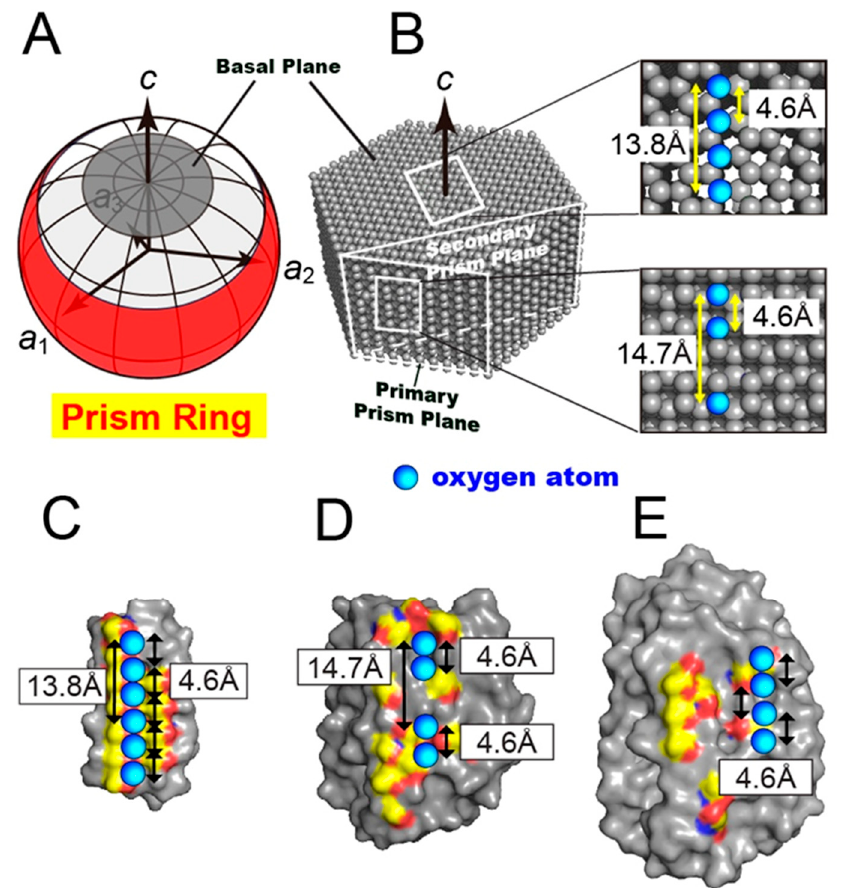
Figure 5. Oxygen atom spacings of a single ice crystal and IBPs. ( A ) Illustration of the prism ring, indicating the Anp IBP-bound area on a single ice crystal hemisphere. ( B ) Hexagonally arranged water molecules that are the constituents of the single ice crystal hemisphere. Only the oxygen atoms are only indicated. The basal plane is the top surface of ( A , B ). The oxygen atoms separated by 4.6 and 14.7 Å are unique constituents of the primary and secondary prism planes as well as the prism ring. ( C ) IBS of Tm IBP has six hollows to trap the water molecules (cyan) at regular intervals. They show a close match to the O-atom distances of the basal plane (4.6 and 13.8 Å). ( D ) Four linearly arrayed hollows observed on the IBS of Anp IBP to trap the water molecules. Their intervals perfectly match the distance between the oxygen atoms comprising the prism ring (4.6 and 14.7 Å). ( E ) Hollows with 4.6-Å intervals observed on Tis IBP6, which possesses the ability to bind to multiple ice planes.